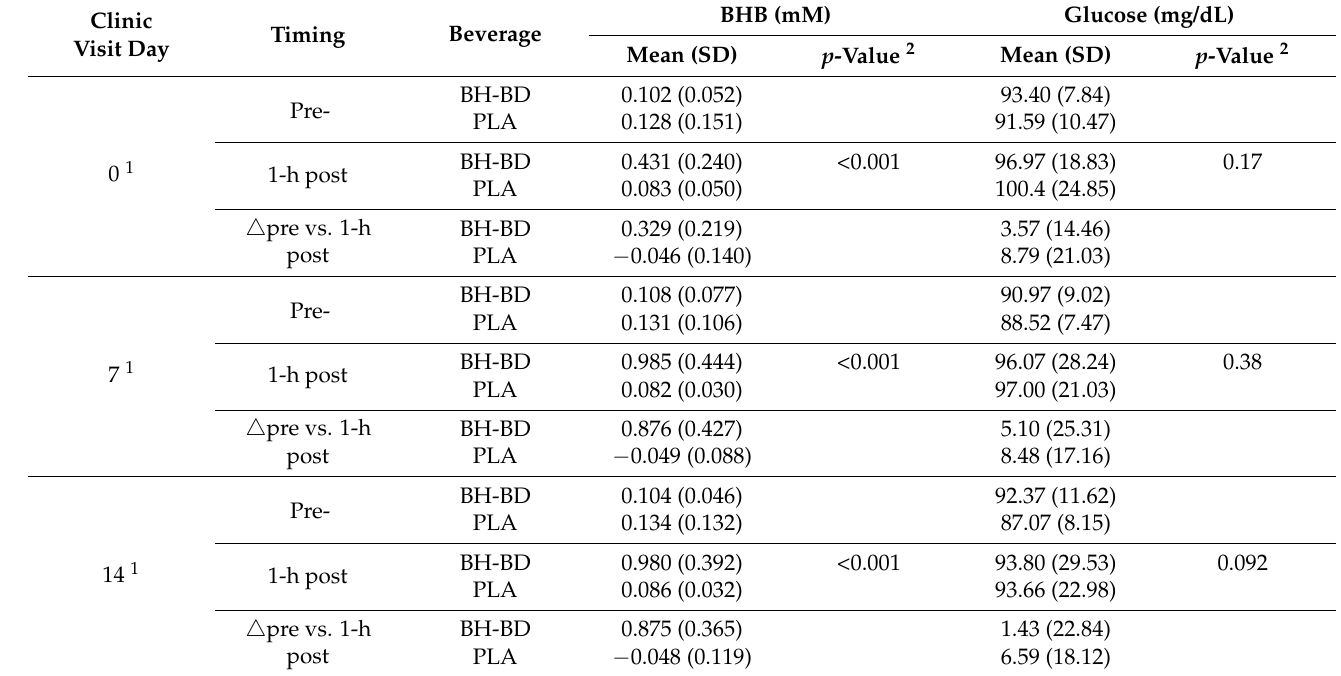
Table 6. Serum BHB and glucose concentrations in healthy participants either before or 1 h after consuming BH-BD ( n = 30) or placebo ( n = 29) during clinic